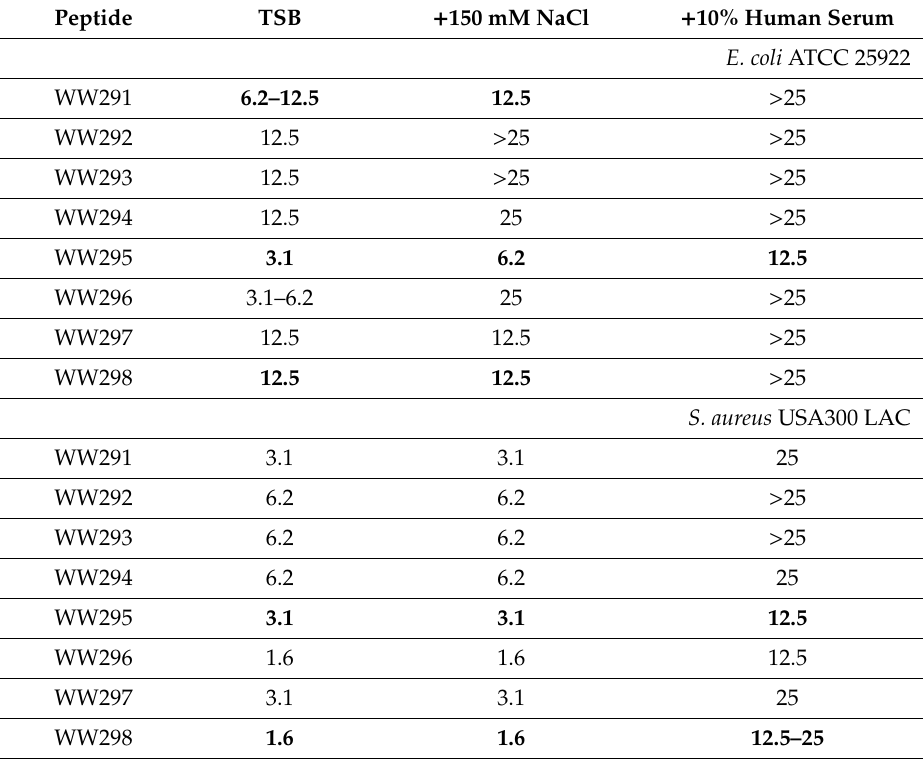
Table 3. E ff ects of salt and serum on peptide activity (in µ